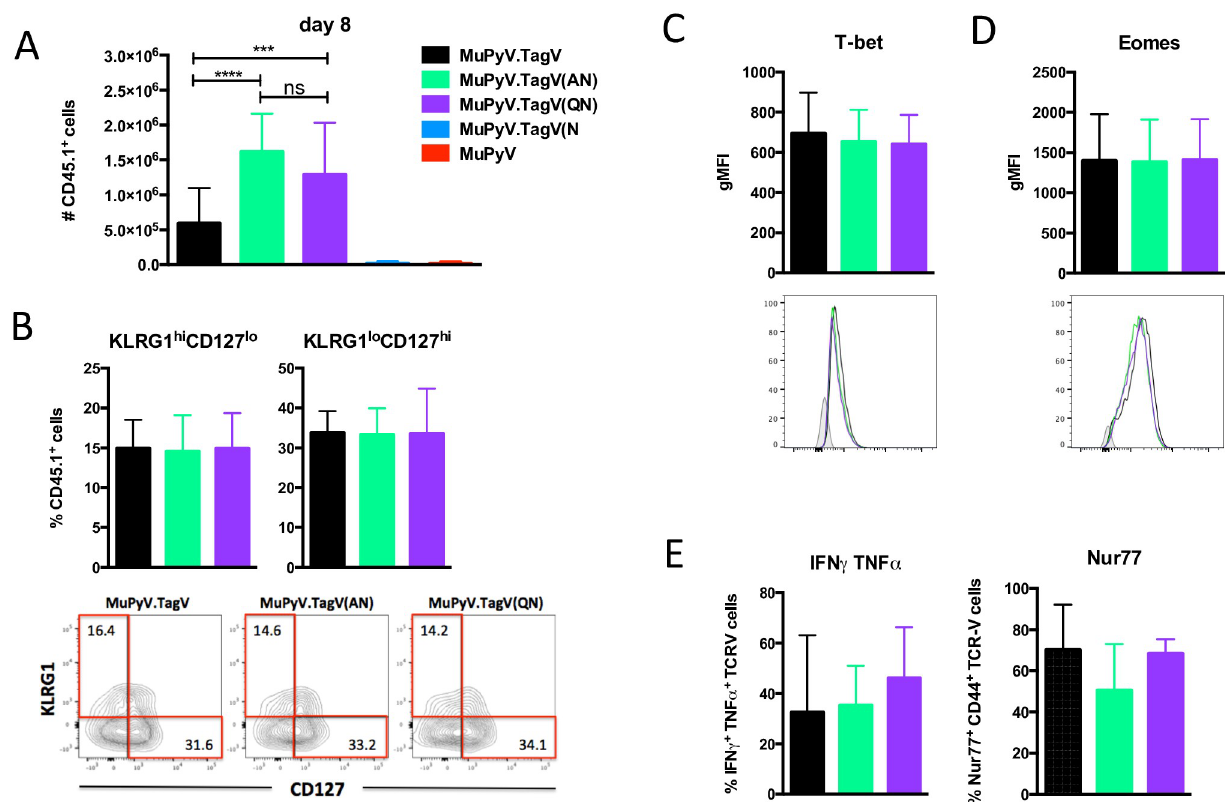
Fig 3. TCR stimulation strength does not affect CD8 T cell memory differentiation in the spleen during acute infection. TCR-V cells were transferred i.v. into B6 mice one day prior to infectionwith TagV analogue viruses and sacrificedat day 8 p.i. (A) Number of TCR-V cells in the spleen. (B) Percent of TCR-V cells that are KLRG1 hi CD127 lo (left panel)or KLRG1 lo CD127 hi (right panel). Representative dot plots shown. (C-D) Expression of T-bet (C) and eomes (D) by splenicTCR-V cells. Representative histograms shown. Gray shadedhistograms represent fluorescence-minus-one controls. (E) IFN γ and TNF α co-expression (left panel)and Nur77 expression (right panel)in splenocytes stimulated for 5 h ex vivo with 1 μ M TagV peptide.Mean ± SD plotted. N = 9–18 mice from 3–6 independent